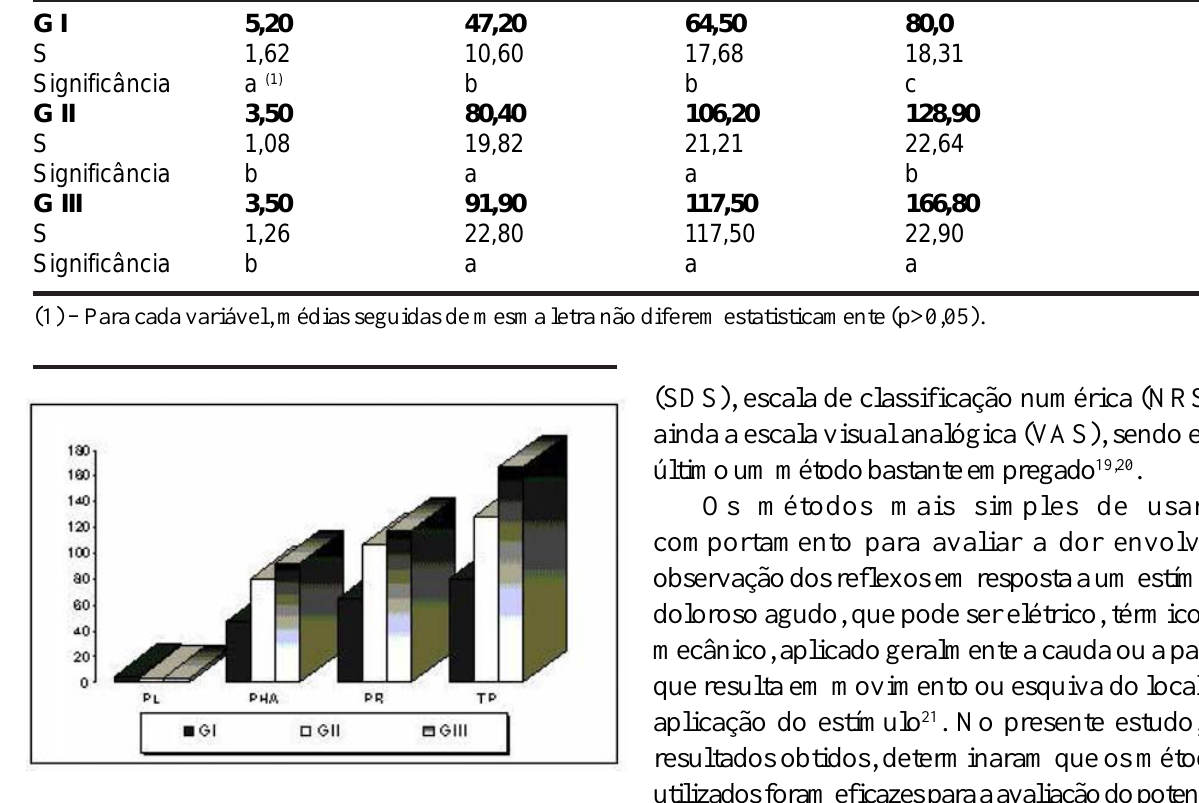
FIGURA 5 - Valores médios referentes às variáveis: período de latência, (PL) hábil anestésico ,(PHA) recuperação (PR) e tônus postural (TP) em minutos, de cães (n=10) tratados com 1 mg/ kg de levomepromazina, 0,2 mg/kg de midazolam e 15 mg/kg de quetamina (GI), pré- tratados com butorfanol (G II) ou pela buprenorfina (G III) segundo